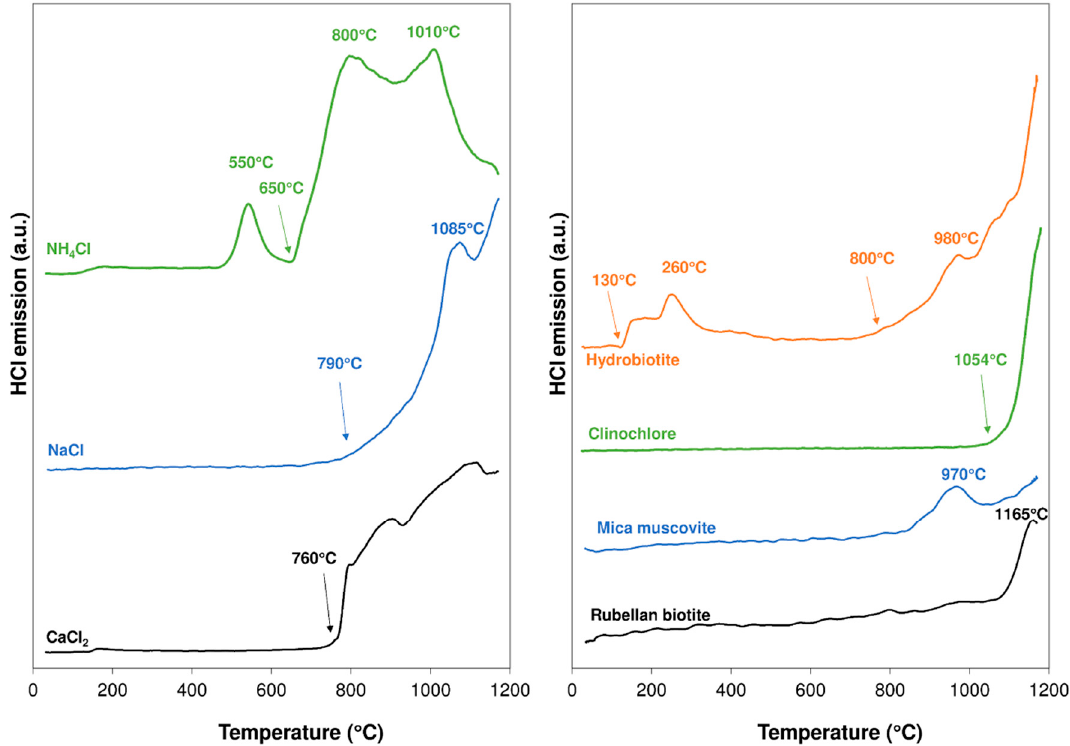
Figure 3. HCl emission evolution of analyzed samples.